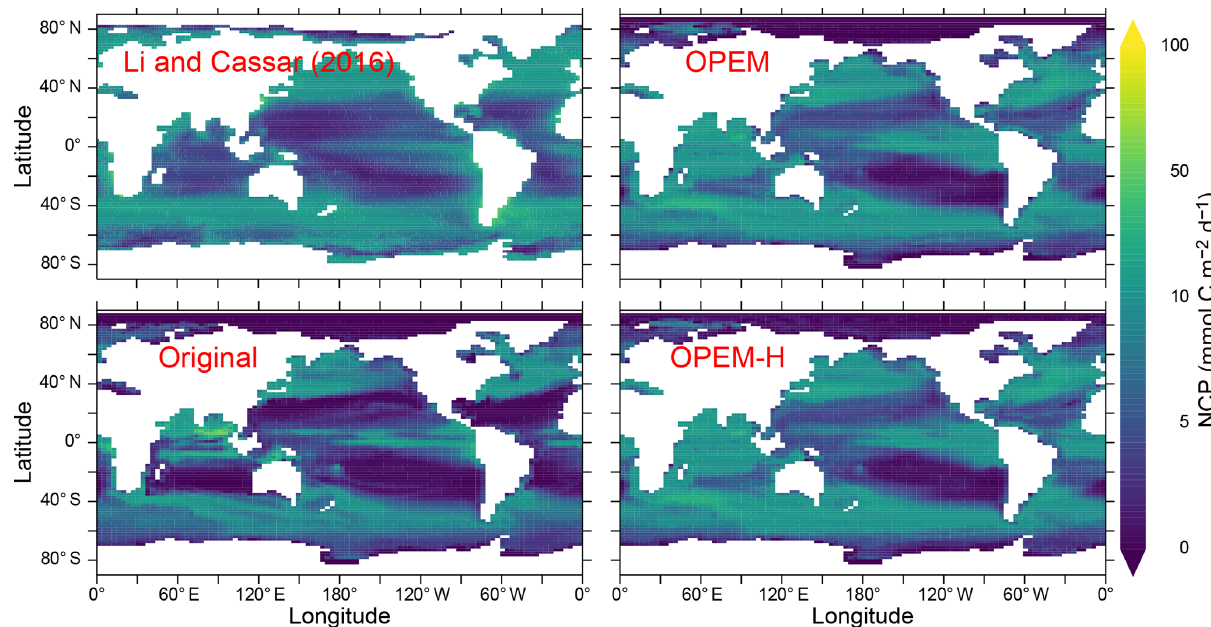
Figure 12. Annually averaged distribution of NCP in the upper 100m. Global oceanic NCP is 13.5PgCyr − 1 for the satellite-based estimate from Li and Cassar (2016) and 9.3, 12.9, and 13.0PgCyr − 1 for the original, OPEM, and OPEM-H simulations, respectively. The data from Li and Cassar (2016) are 1997–2010 averages of their genetic-programming results for SeaWiFS, aggregated into a monthly climatology on the UVic grid and then temporally averaged with missing data treated as